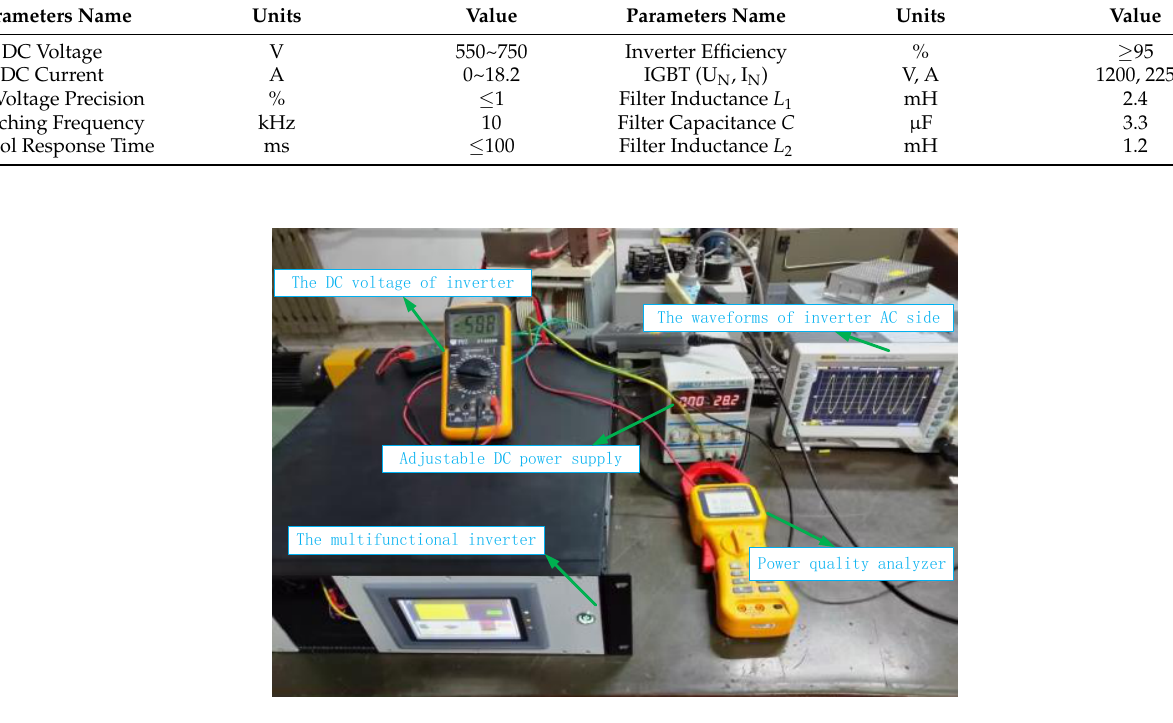
Figure 19. The experimental